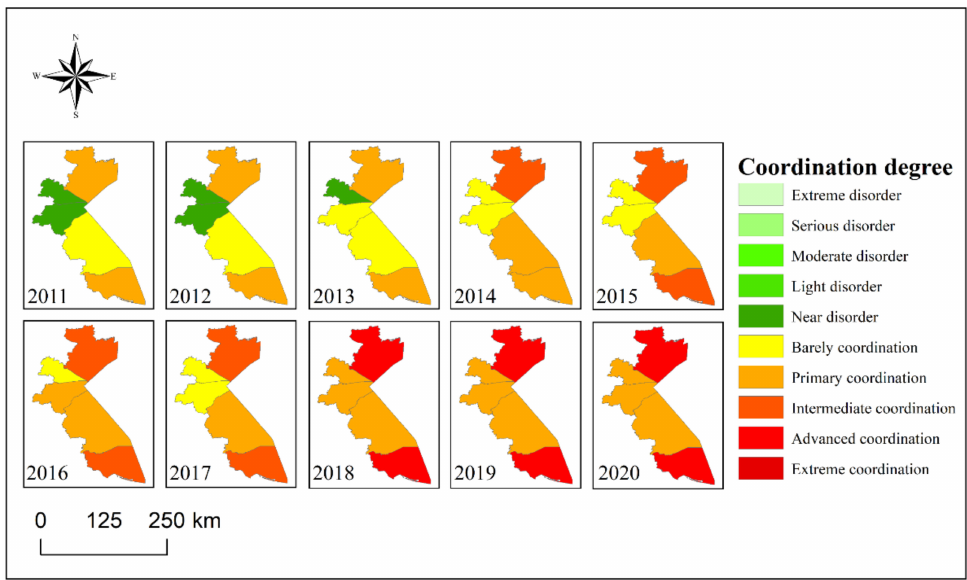
Figure 5. The characteristic of coordination degree of EE, SOC, and ECO from